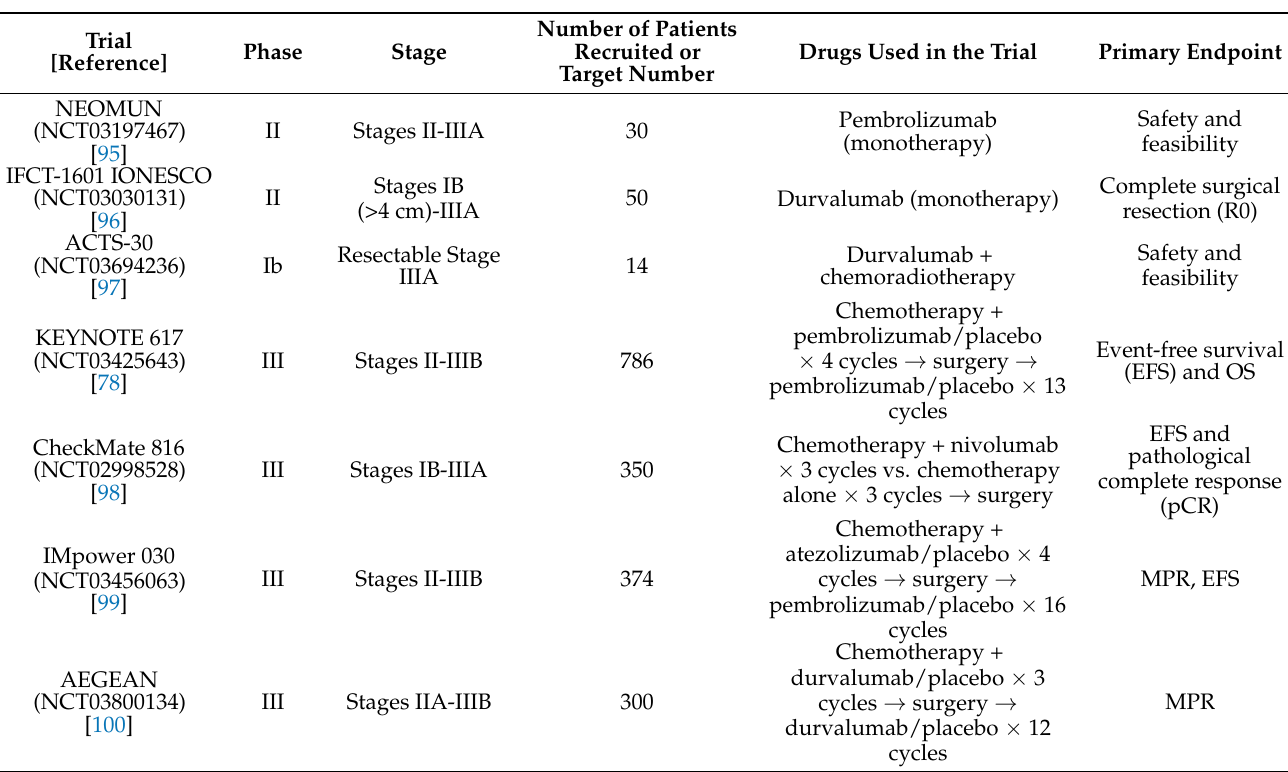
Table 3. Ongoing clinical trials using immunotherapy with or without chemotherapy as neoadjuvant therapy for resectable NSCLC